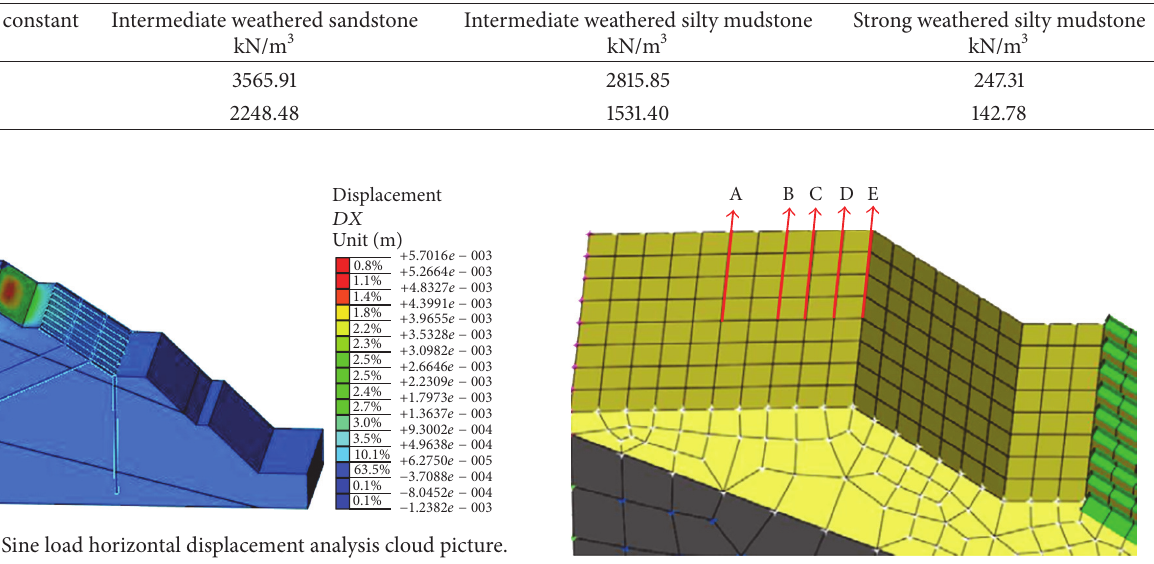
Table 4: Damping constant of every stratum.